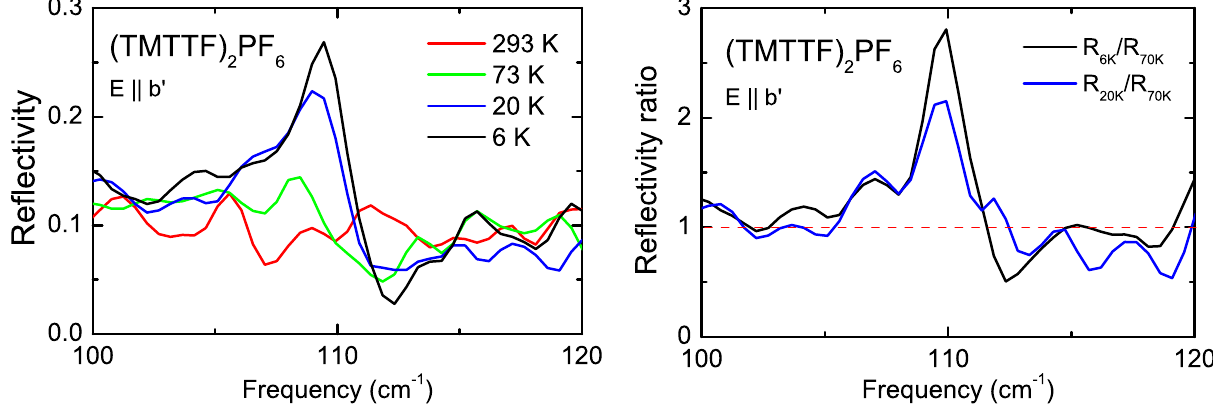
Figure 26. Far-infrared reflectivity spectra of (TMTTF) obtained for E (cid:107) b (cid:48) polarized light. A feature at 110 cm − 1 gradually develops as the temperature is reduced below T is normalized to the T = 70 K